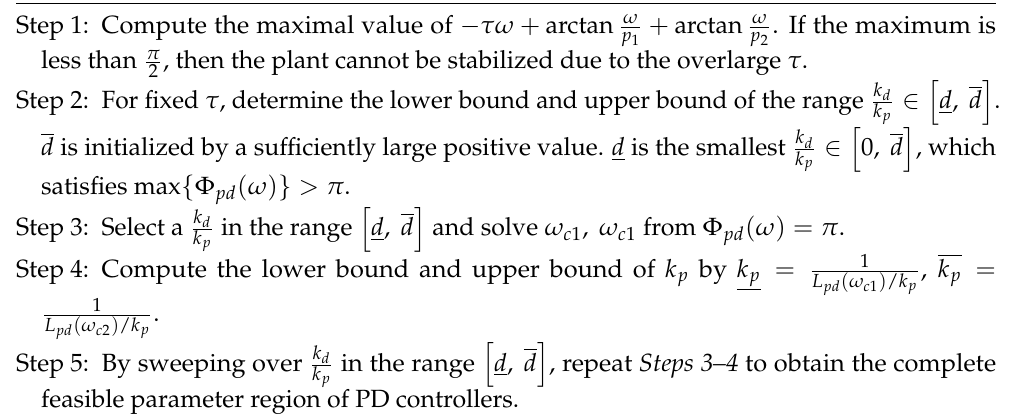
Algorithm 1 The algorithm for the feasible PID parameter region of the plant